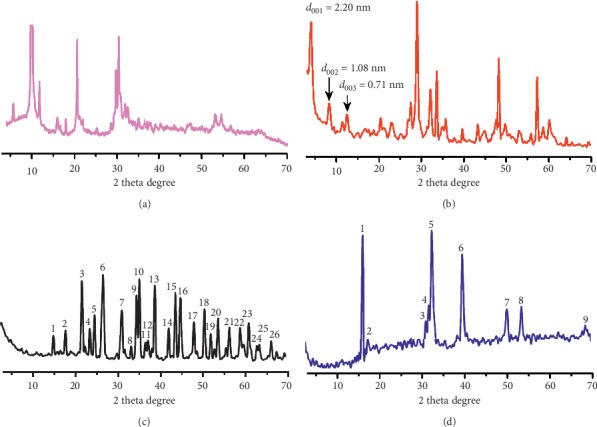
XRD patterns of (a) Dy2(OH)5NO3.nH2O, (b) Dy2(OH)5(C28H20O6S2)0.5.nH2O, (c) Dy2(OH)5(C28H20O6S2)0.5@Pb.nH2O, and (d) Dy2(OH)5(C28H20 O6S2)0.5@Cu.nH2O.